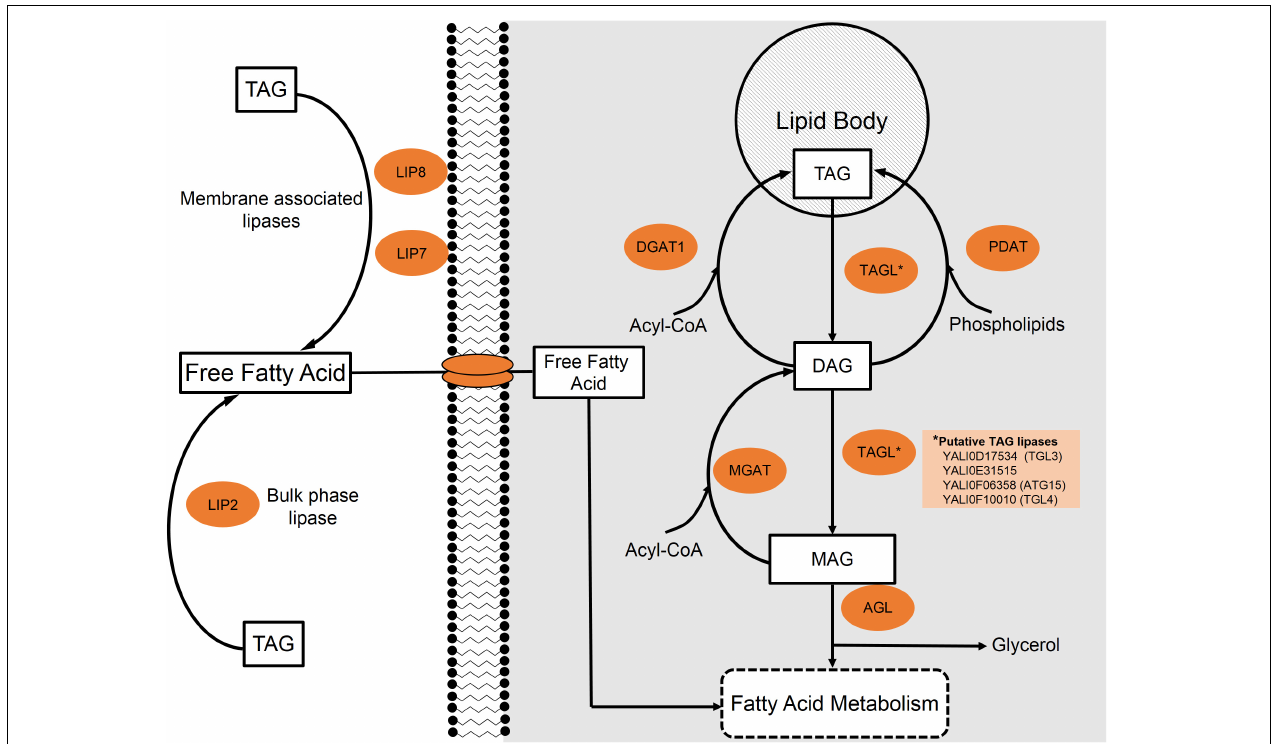
FIGURE 3 | Lipid metabolism of triacylglycerides (TAGs) in Y. lipolytica . Extracellular and intracellular TAGs are processed through a stepwise degradation pathway focusing around either extracellular lipases (Lip2, Lip7, and Lip8) or internal triacylglycerol lipases (TGLs),